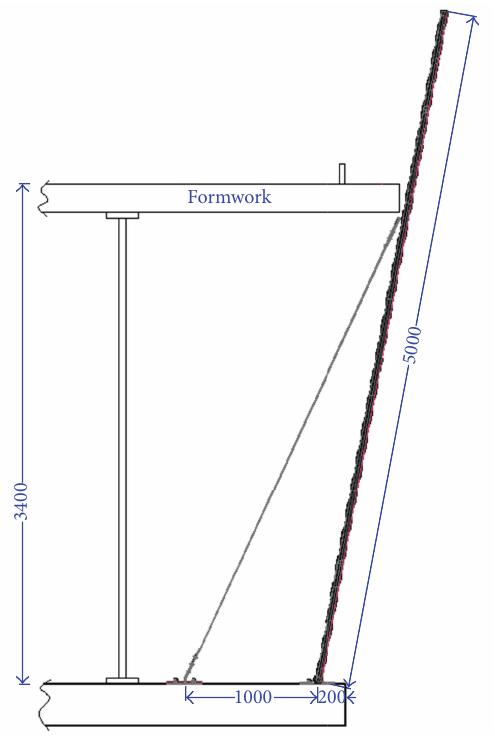
Figure 5: Mounting position of the